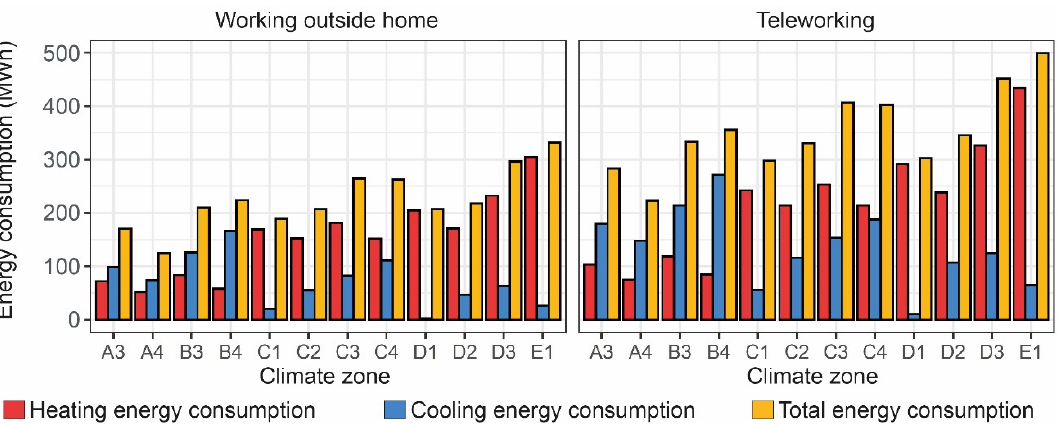
Figure 7. Annual energy consumption of the building without improving its envelope in the current scenario.